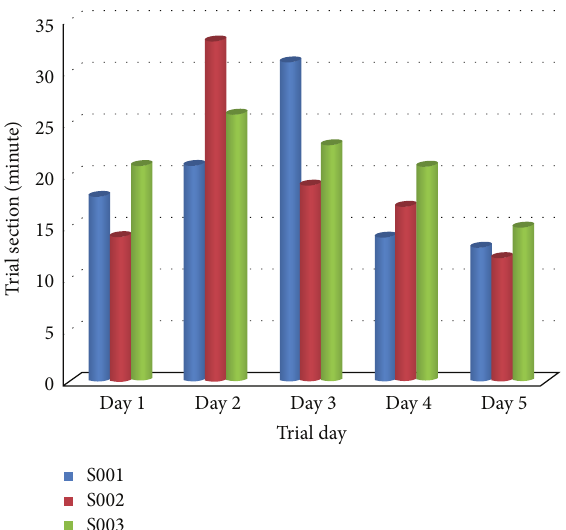
Figure 8: Trial period of all subjects on each day.